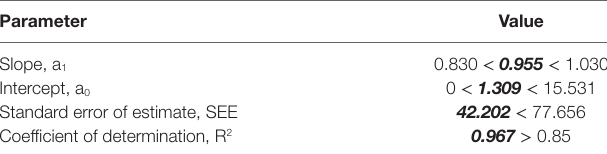
TaBle 2 | EPA specified Statistical Criteria for drive cycle torque. Parameter